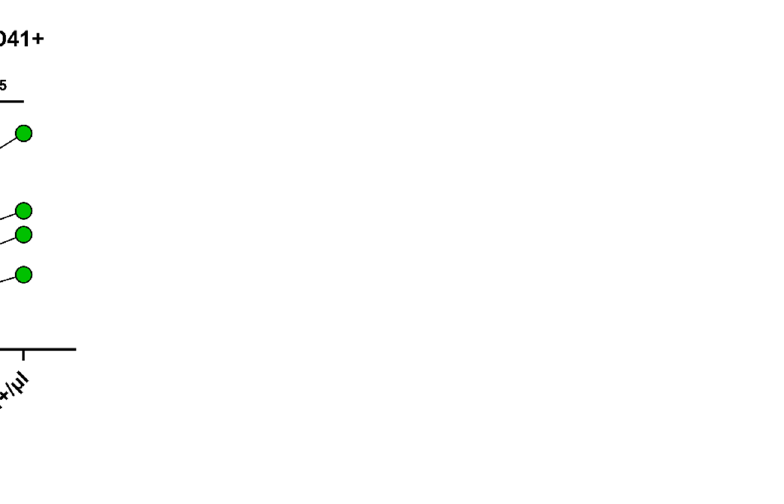
Figure 2. CD41+ circulating EVs in the peripheral blood of athletes recovering from muscle injuries. The graph shows absolute counts a of CD41+ circulating EVs, analyzed before (T0, blue dots) and after (T1, green dots) the rehabilitation program.